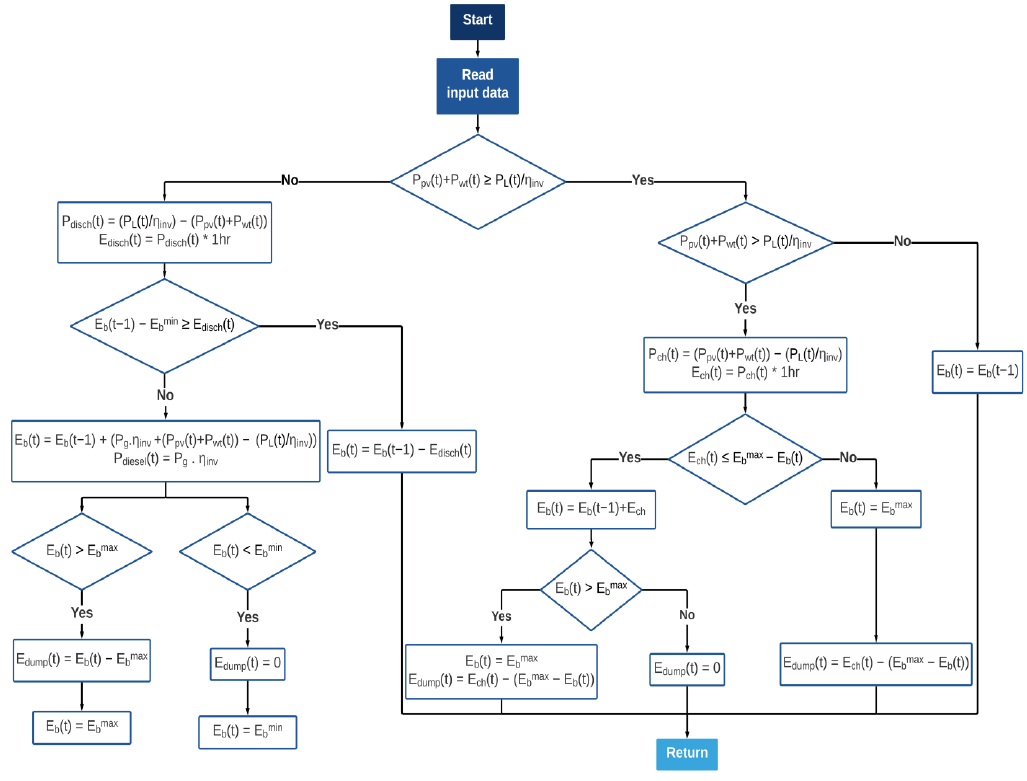
Figure 9. The proposed rule-based energy management strategy.